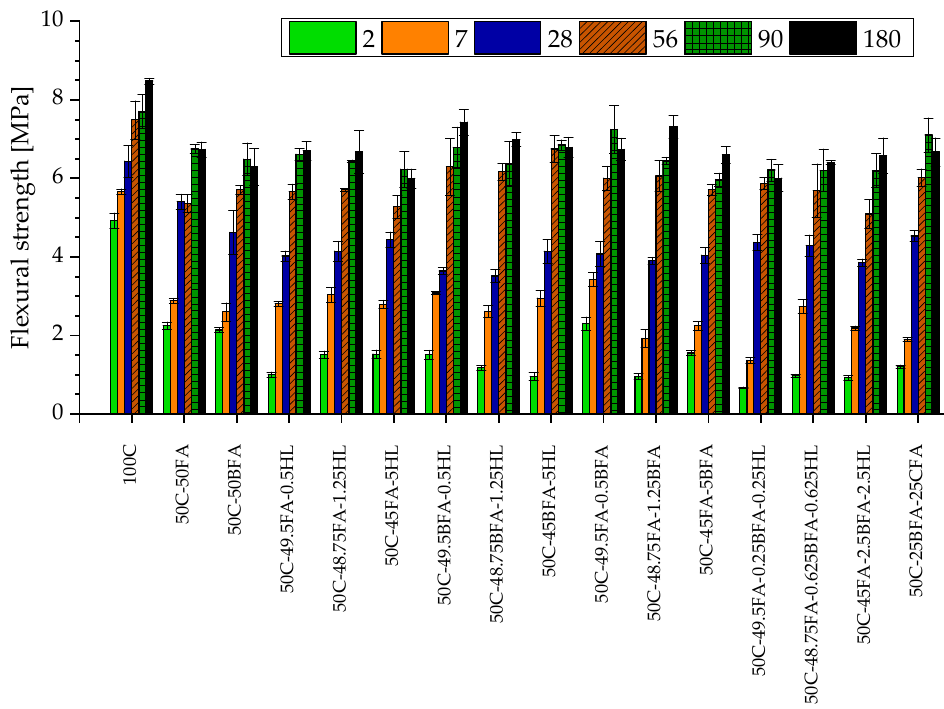
Figure 5. Evaluation of flexural strength values of mortars with the curing period for 2, 7, 28, 56, 90, and 180 of curing.